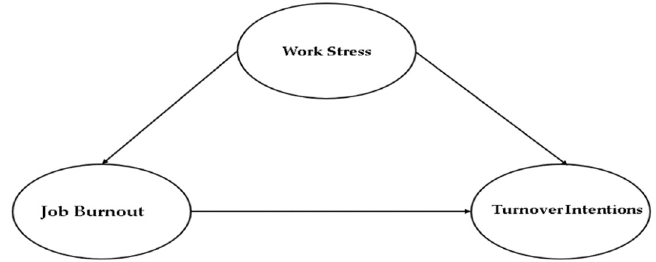
Figure 1. The research conceptual